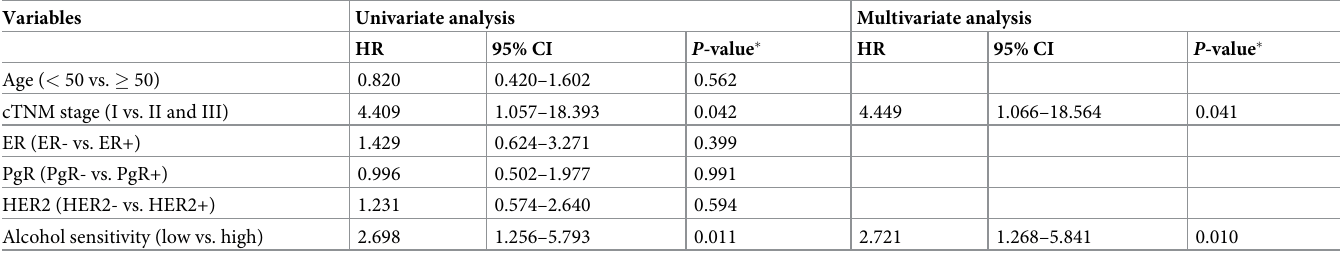
Table 6. Univariate and multivariate analyses of risk factors for bone metastases.